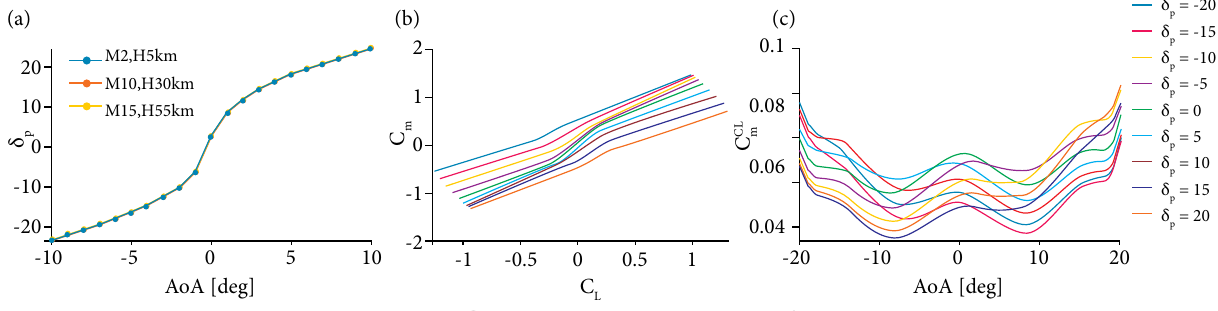
Figure 10. Trim angle and static stability of